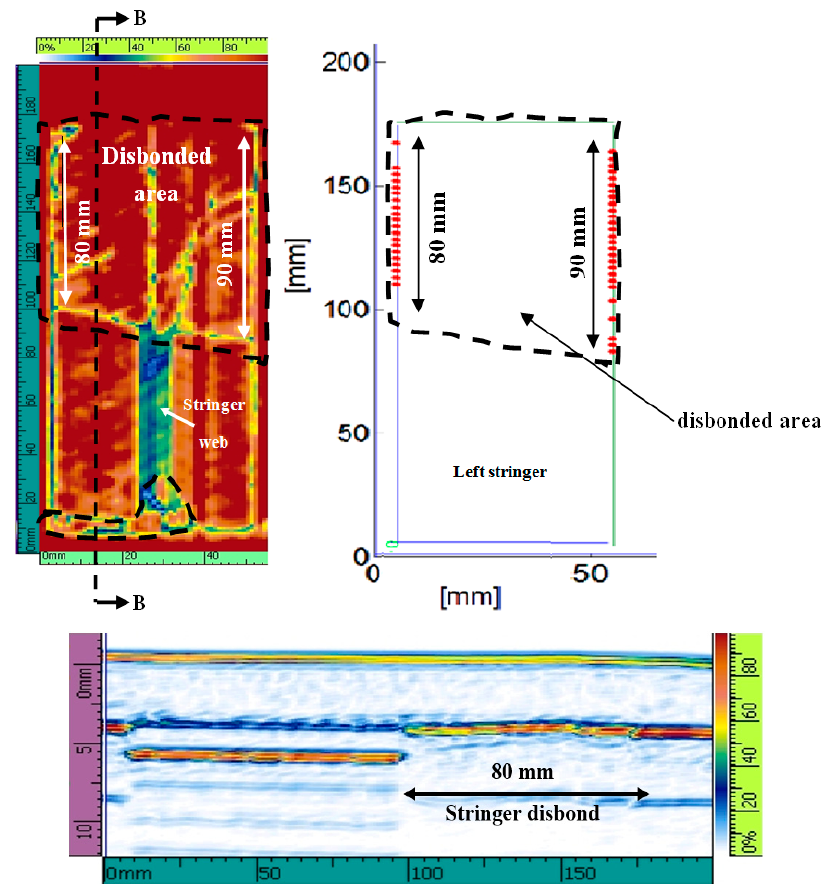
Figure 11. Panel PNL1: left stringers C-scan ( upper ) and B–B longitudinal section with B-scan view ( bottom )—scan length 200 mm.